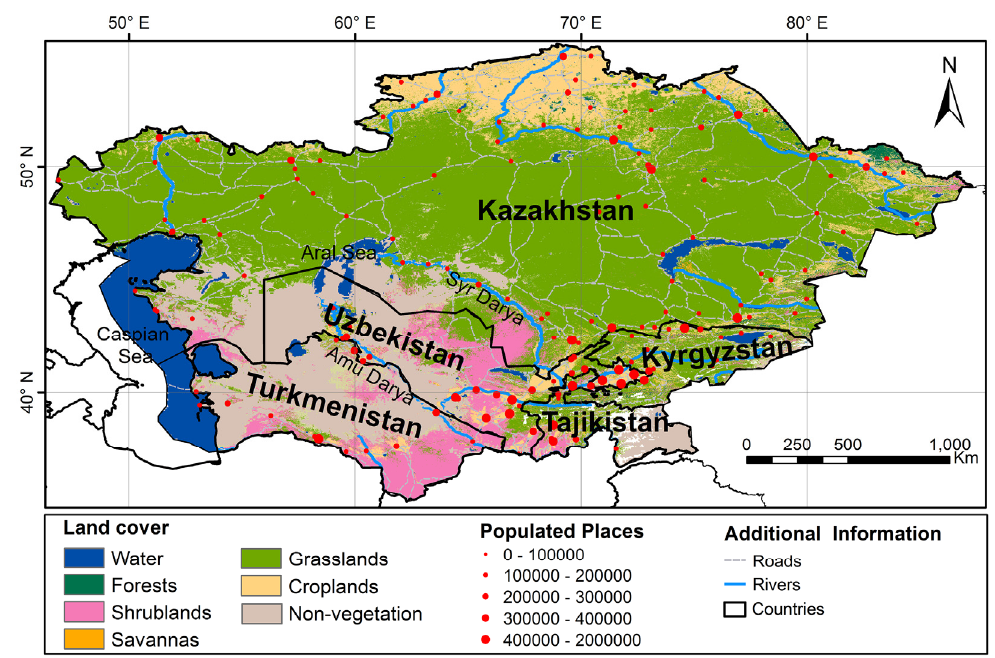
Figure 1. Map of study area. The land cover data was adapted from the 500 m Moderate Resolution Imaging Spectroradiometer (MODIS) land cover product (MCD12Q1). Data for population, roads, rivers, lake centerlines, and country boundaries were downloaded from the Natural Earth database